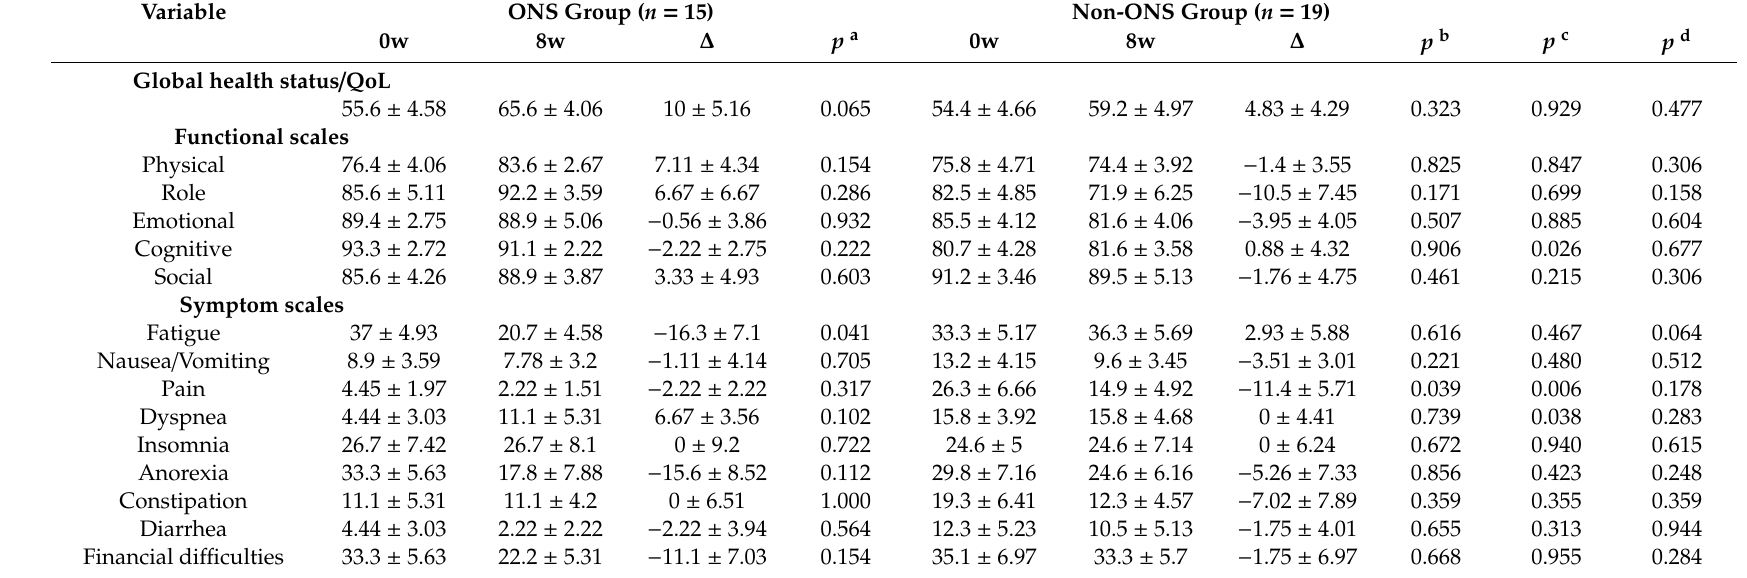
Table 3. The changes of the European Organization for Research and Treatment of Cancer (EORTC) Quality of Life Questionnaire Core 30 (QLQ-C30) scores between